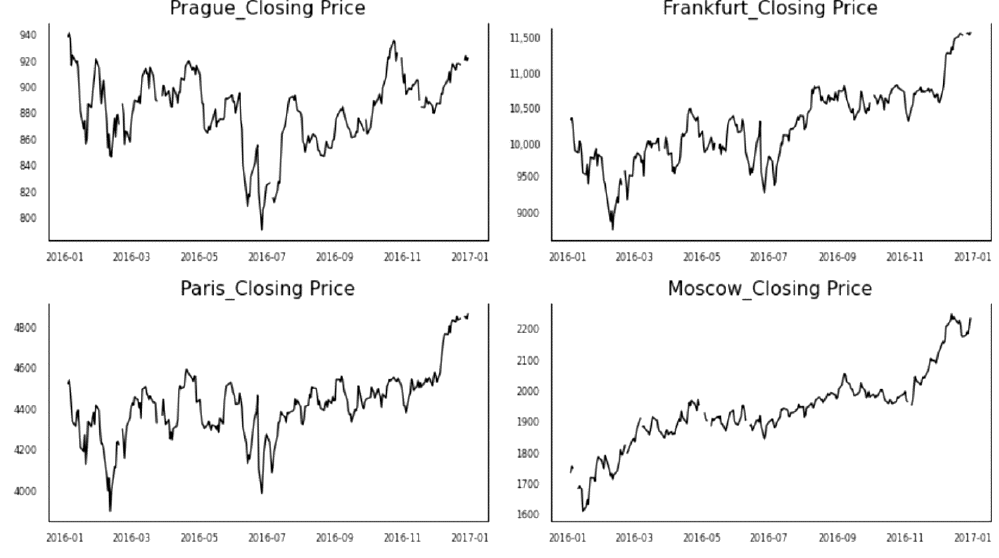
Figure 2. Closing price of four stocks.